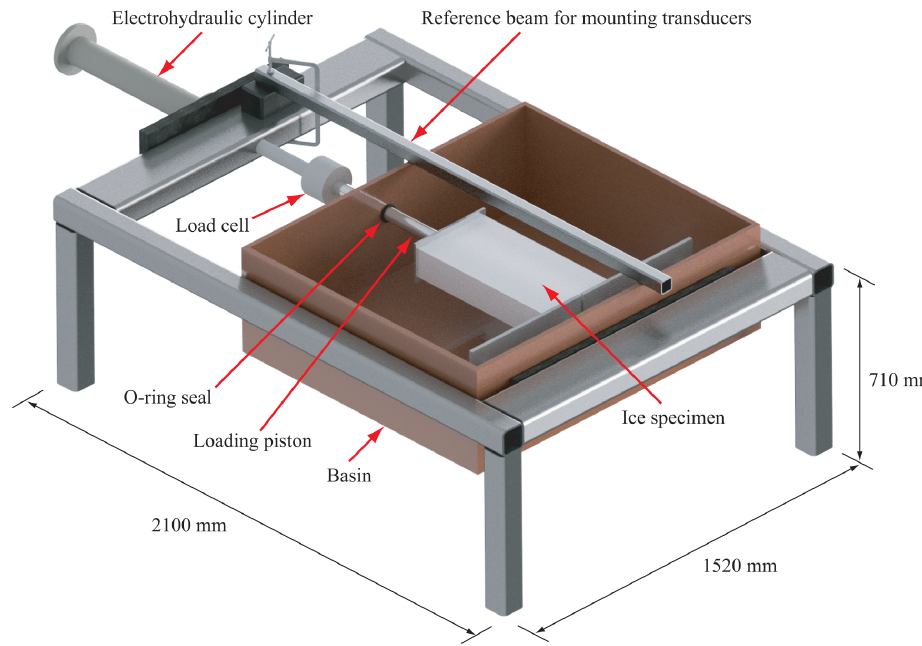
Figure 3. A sketch of the test rig used in the experiments. The inner dimensions of the basin are 1320mm × 1280mm × 400mm.